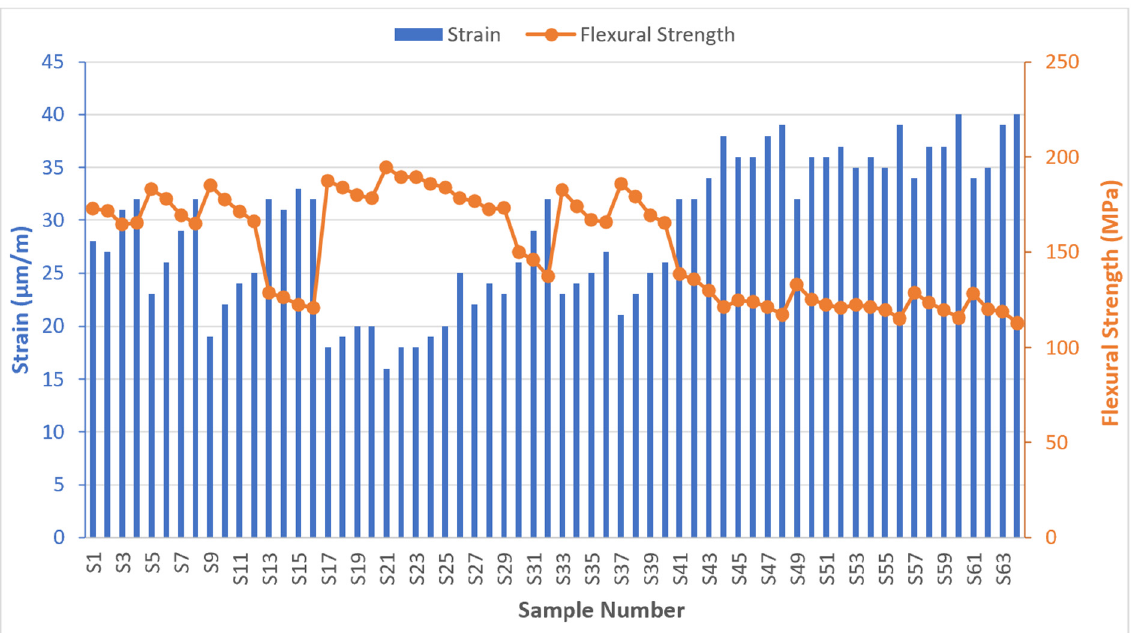
Figure 9. Correlation between strain and flexural strength.